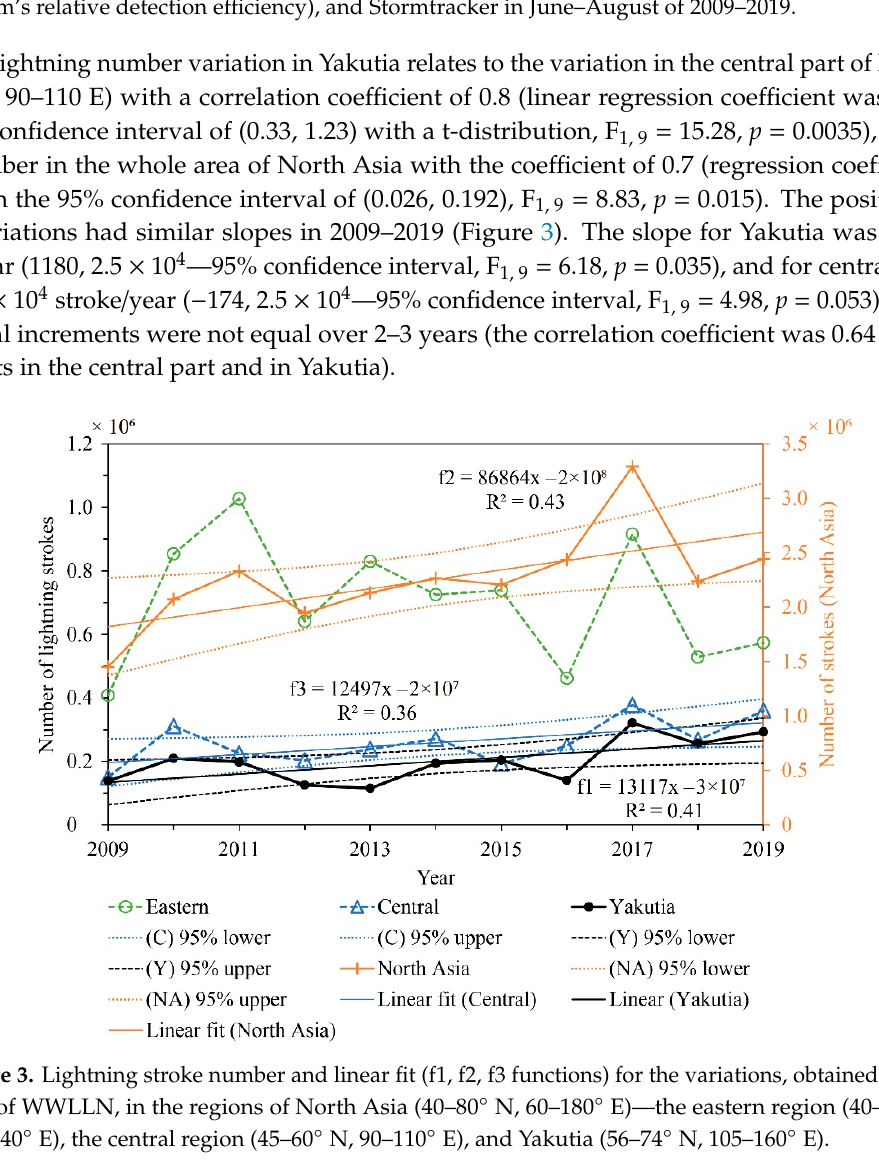
Figure 2. The sferics number detected by the lightning direction finder, WWLLN (data corrected by the